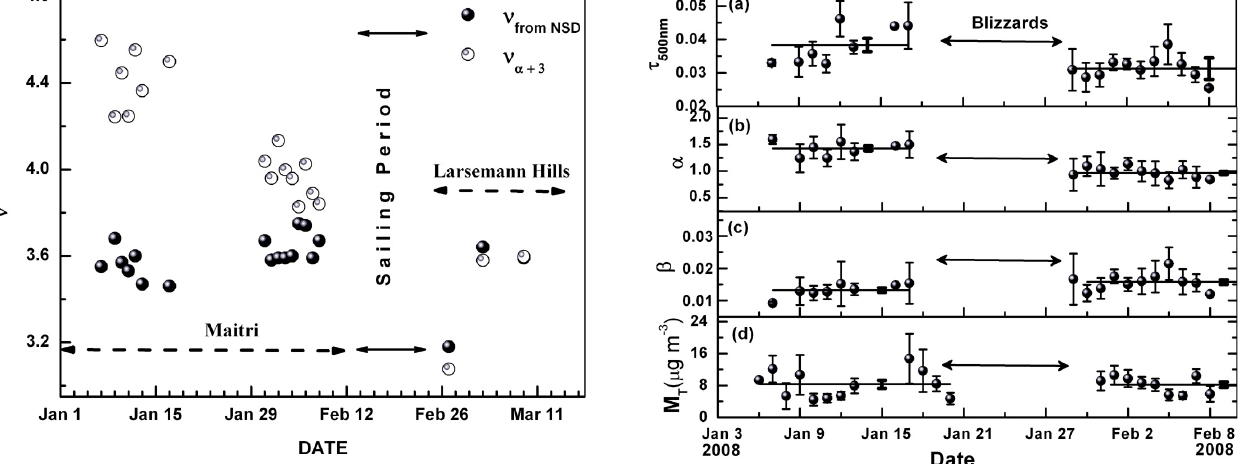
Fig. 10. Aerosols optical depth ( τ) , Angstrom exponent α , colum- nar loading “ β ” and total mass concentration ( M T ) before and after the blizzard at Maitri. The vertical line passing through the circles are the standard deviation from the mean value whereas the hori- zontal line represents the mean value before and after the blizzard event whereas the thick vertical line is the standard